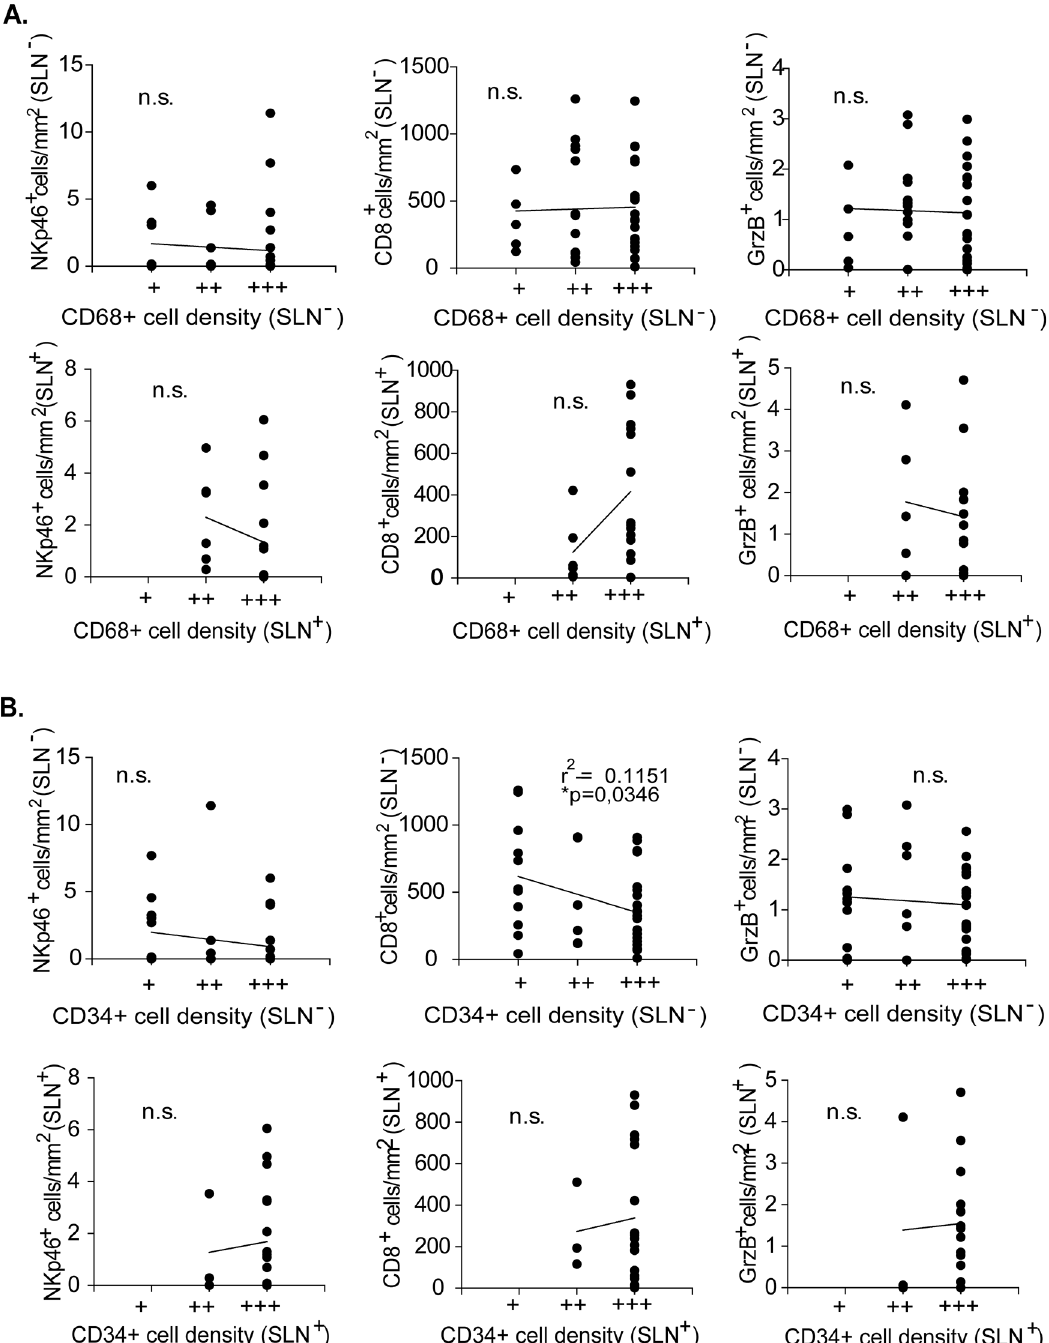
Fig 4. Correlation analyses between numbers of cytotoxic immune cells (GrzB + , NKp46 + , CD8 + T cells) and the densities of (A) macrophages or (B) endothelial cells in SLN - and SLN + .